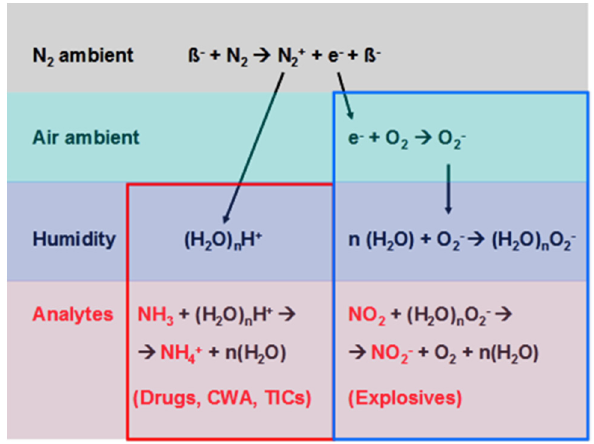
Figure 8. (Top panel) Radioactive ionization of N 2 molecules by high-energy electrons ( β -particles) leading to positive (hydrated protons) and negative (low-energy electrons) ionization products. In the follow-on atmospheric pressure chemical ionization (APCI) processes, the initial ionization products become attached to increasingly higher proton- or electron-affinity molecular species, thus forming positive (left) and negative (right) analyte ions, here represented by NH 3 and NO 2 ones. (CWA: chemical warfare agents; TICs: Toxic industrial compounds). For more details, see [17].